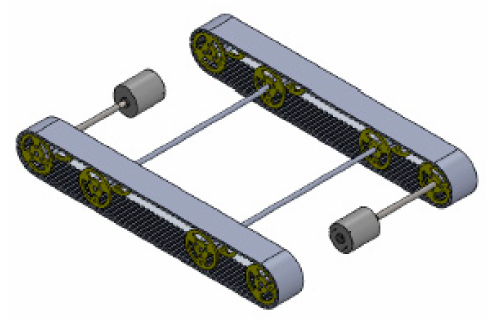
Figure 9. CAD Model of mechanical base.